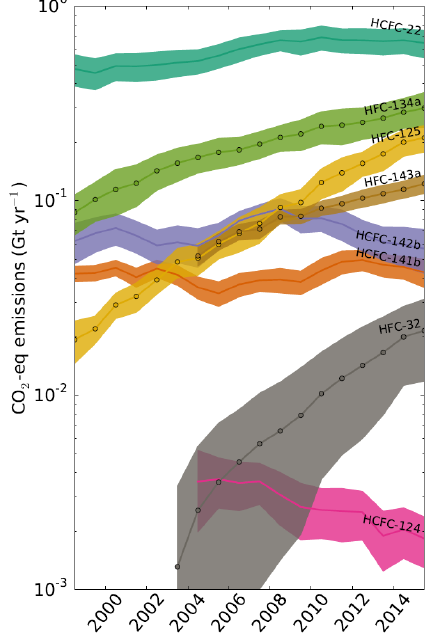
Figure 5. Individual HCFC and HFC carbon dioxide equivalent (CO 2 eq.) emissions (Gtyr − 1 ) derived from the 12-box model. Shading, representing 1 σ uncertainties. Note that for HCFC-124, HFC-143a and HFC-32 we only use GC-MS-Medusa data for these calculations; for all others we use combined GC-MS-ADS and GC- MS-Medusa